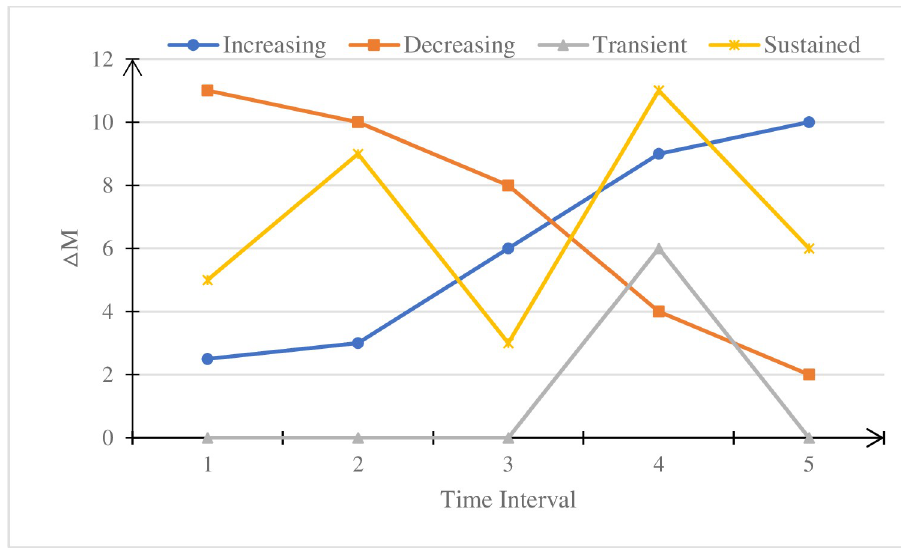
Fig 2. Trajectory of Δ M values of four types of researchers in different time